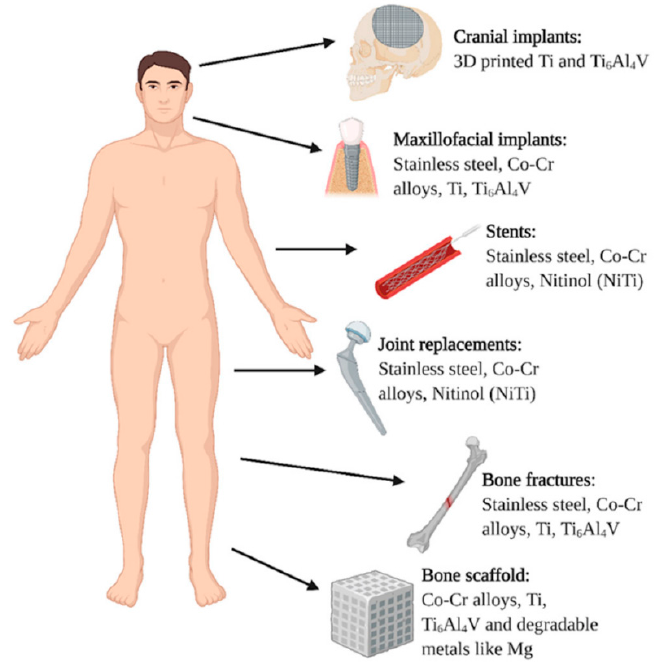
Figure 1. Kinds of metallic implants utilized in the human body. Reprinted with permission from